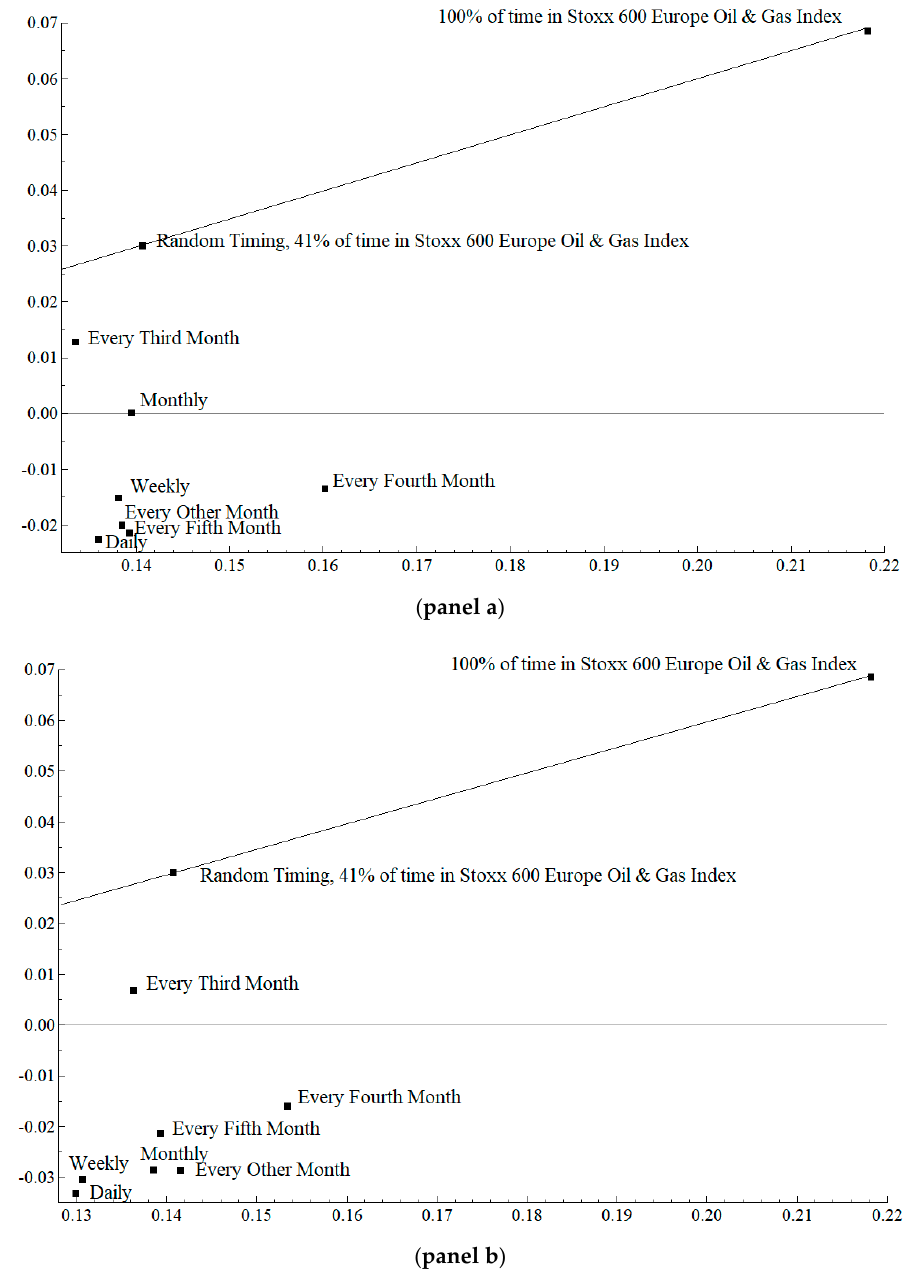
Figure 12. Returns to volatility ratios in Stoxx 600 Europe Oil and Gas Index, 2 December 2008 to 28 September 2018. ( panel a ) Calculated daily, weekly, monthly, every second month, every third month, every fourth month, and every fifth month; ( panel b ) Calculated with maximal rolling window, daily (MA200), weekly (MAW40), monthly (MA10), every second month (MAD5), every third month (MAT4), every fourth month (MAD3), and every fifth month (MAC2).